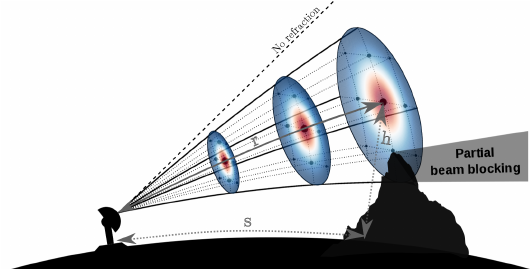
Figure 3. Beam broadening increases the sampling volume with in- creasing range and is caused by the fact that the normalized power density pattern of the antenna (shown in red/blue tones) is not com- pletely concentrated on the beam axis. The blue dots correspond to the integration points used in the quadrature scheme (in this case with J,K = 3 for illustration purposes) and their size depends on their corresponding weights. The effect of atmospheric refraction on the propagation of the radar beam is also illustrated: r is the radial distance (radar range), s is the ground distance, and h the distance above ground of a given radar gate, which need to be esti- mated